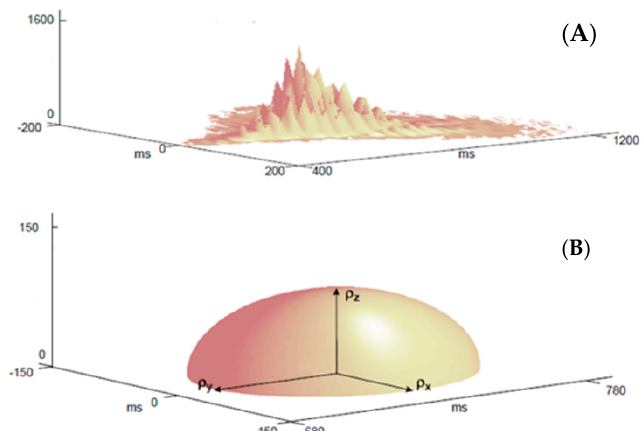
Figure 2. ( A ) Example of a 3D scatter plot presenting the visual representation of the following parameters: number of peaks (N p [adim]), mean distance of peaks from the axis of symmetry (D p [ms]). ( B ) Example of the semi-ellipsoid of inertia illustrating the coordinates of the three radii of inertia : ρ x [ ms ] , ρ y [ ms ] , ρ z [ adim ]